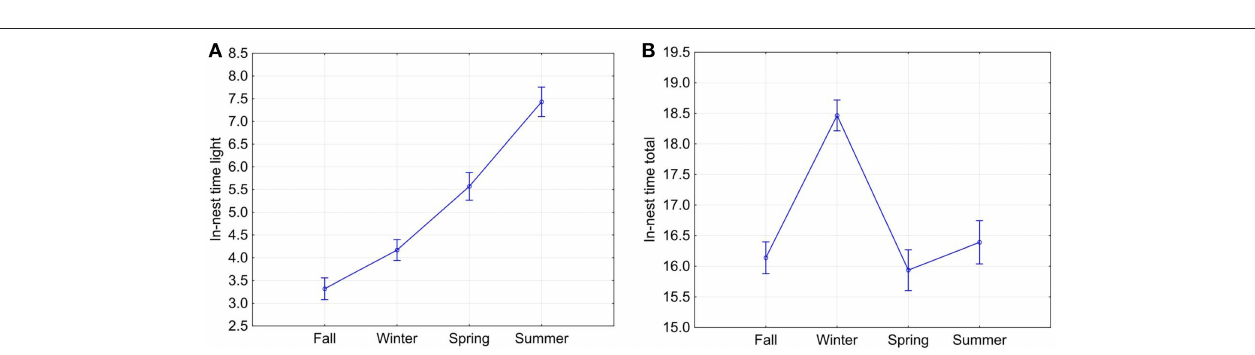
FIGURE 6 | Means (and 95% confidence intervals) of the seasonal in-nest time during daylight (A) and in-nest time during the entire 24-h cycle of day and night (B) . Current effect: Wilks lambda = 0.30196, F (6,2,694) = 368.09, p = 0.0000.